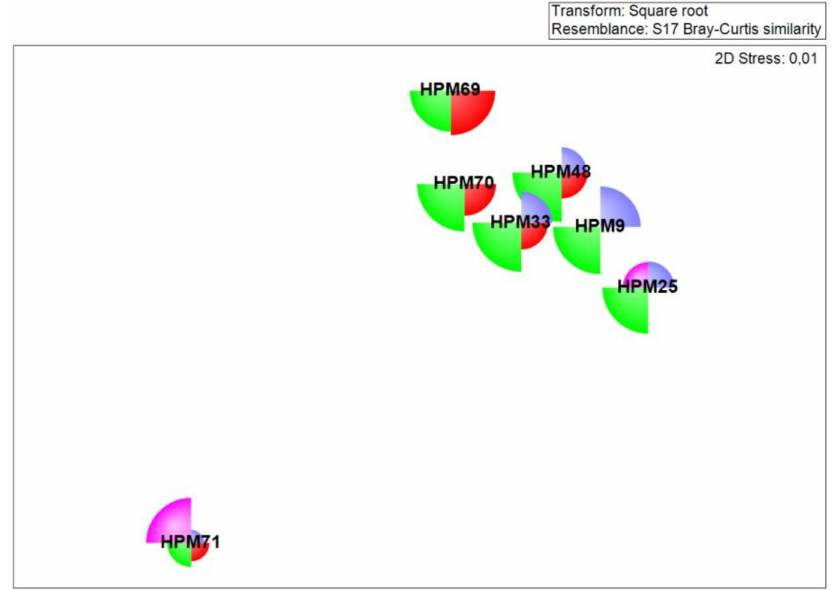
Figure 3. Non-metric multidimensional scaling (nMDS) plot of samples using the square root-transformed diatom abundance data, overlaid with the segmented bubble plot showing the contribution of four dominant diatom taxa in each sample: Achnanthes elongata (blue), Berkeleya cf. fennica (purple), Chelonicola sp. (red), and Poulinea lepidochelicola